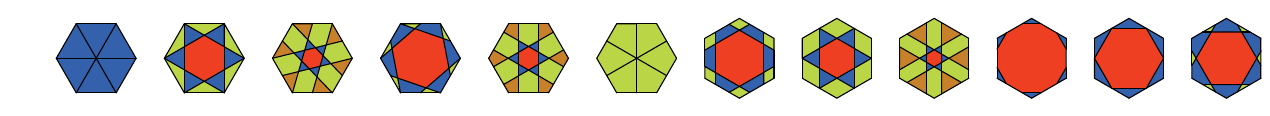
Figure 40. Hexagon